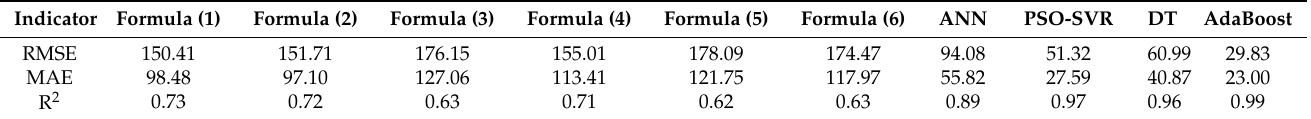
Table 5. Result comparison between machine learning and traditional empirical models.